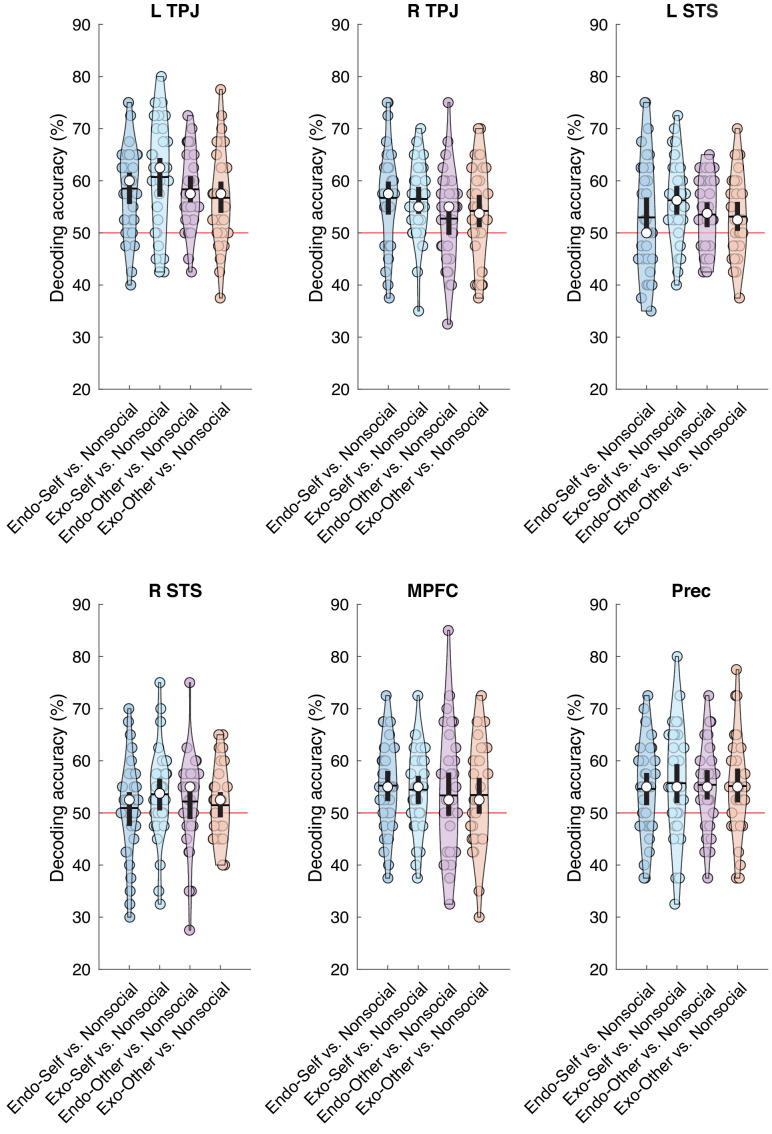
Decoding social versus nonsocial stories within the six ROIs.Violin plots showing mean (black horizontal line) and median (white circle) decoding accuracy (%), 95% confidence interval around the mean based on bootstrap distribution (black vertical line), a kernel density estimation (shaded area), and individual data points for each of the six ROIs. The horizontal red line indicates chance decoding.